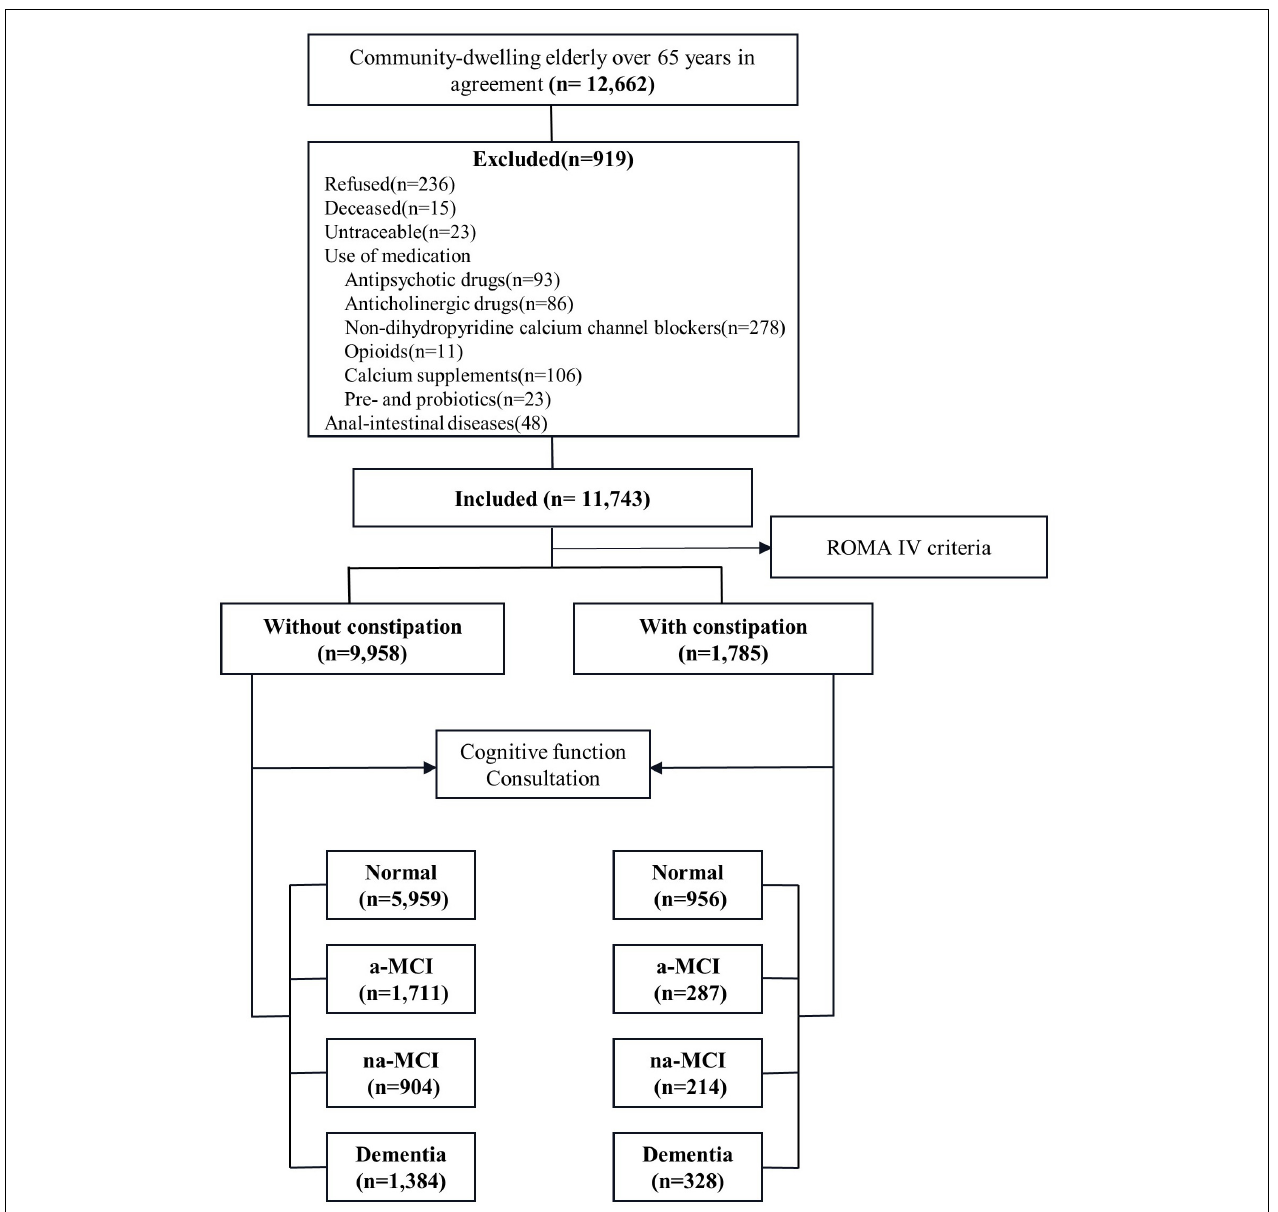
FIGURE 1 | Flow of